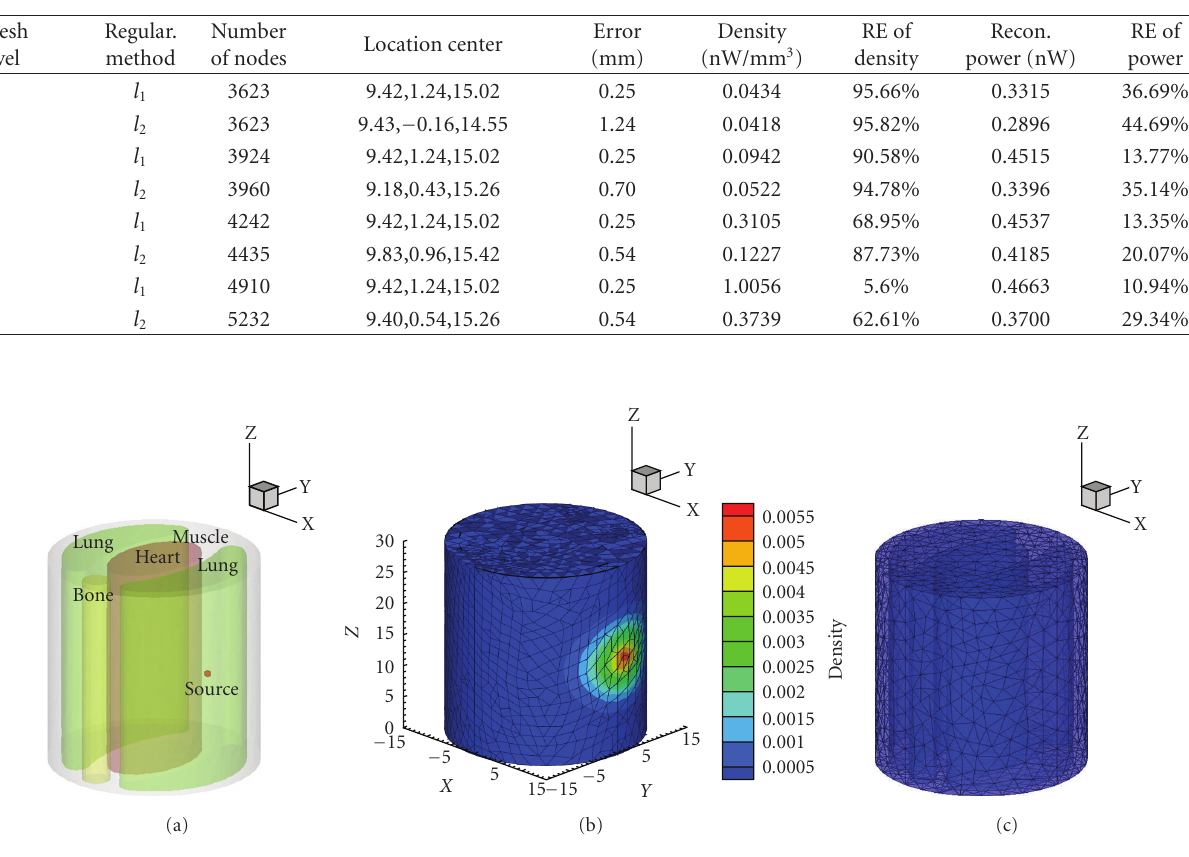
the noise involved in real BLT experiment, 10% random Gaussian noise was added to synthetic